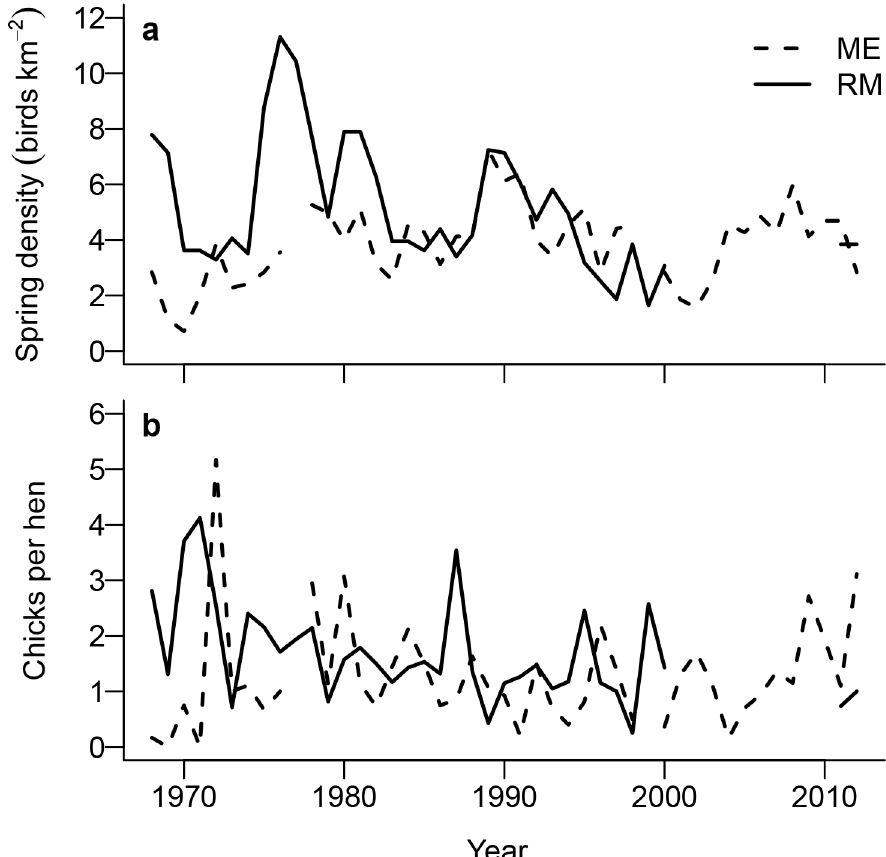
Fig 2. Temporal variation in population density and reproductive success (chicks per hen) of white- tailed ptarmigan in Colorado, USA at Mt. Evans (ME; 1968 – 2012; black dashed line) and Trail Ridge at Rocky Mountain National Park (RM; 1968 – 2000, and 2011 – 2012; black solid line). (a) Spring density of ptarmigan by year. (b) Number of chicks per hen in breeding population by year.